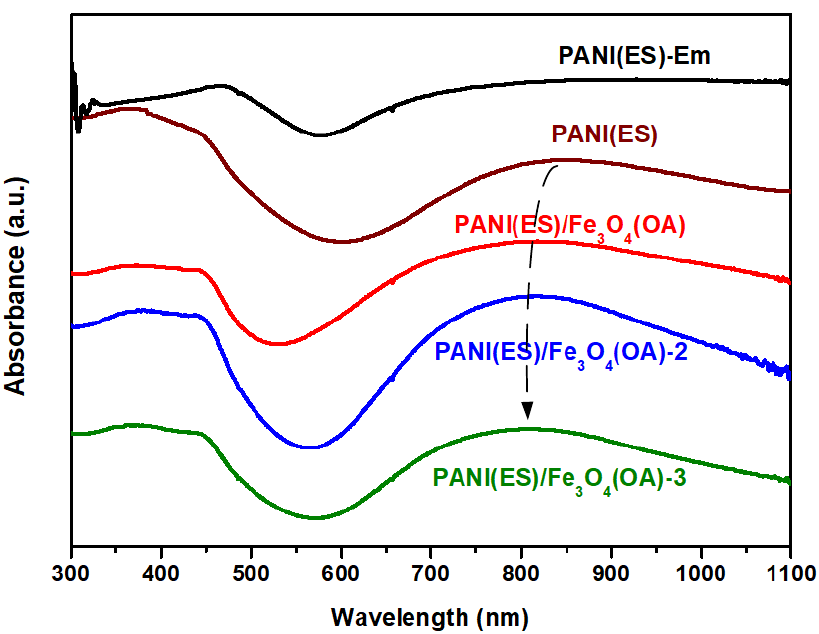
7 of 3 O 4 (OA) composites.